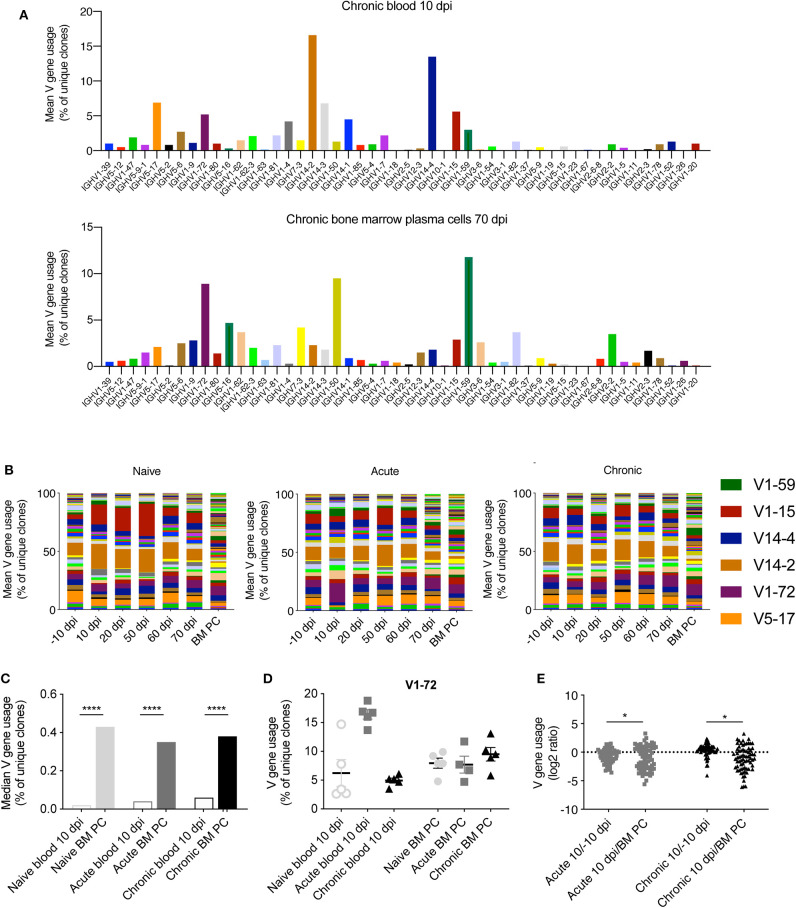
Distinct germline gene usage in blood and BM PC repertoires. (A) Percent of unique IgM clones using the indicated subset of IgH V gene in a single chronically infected mouse at either the blood repertoire 10 dpi (top) or in the bone marrow plasma cell repertoire 70 dpi (bottom). (B) The average percent of unique IgM clones using a given V gene for each cohort. Colors correspond to distinct V genes and the value corresponds to the percentage of usage. Selected genes are highlighted. (C) Median V gene usage across all V genes for each cohort. (D) The percent of unique IgM clones using IgH V1-72 in the blood repertoire 10 dpi or in the BM PC compartment 70 dpi. (E) The log2 ratio quantifying the up- or down-regulation of a given V gene at the indicated time points. Each point corresponds to a single V gene. Positive values indicate increased usage across the cohort in the blood repertoire 10 dpi compared to either −10 dpi (left) or BM PC 70 dpi (right). *p ≤ 0.05, ****p ≤ 0.0005, not significant (n.s.) p > 0.05.